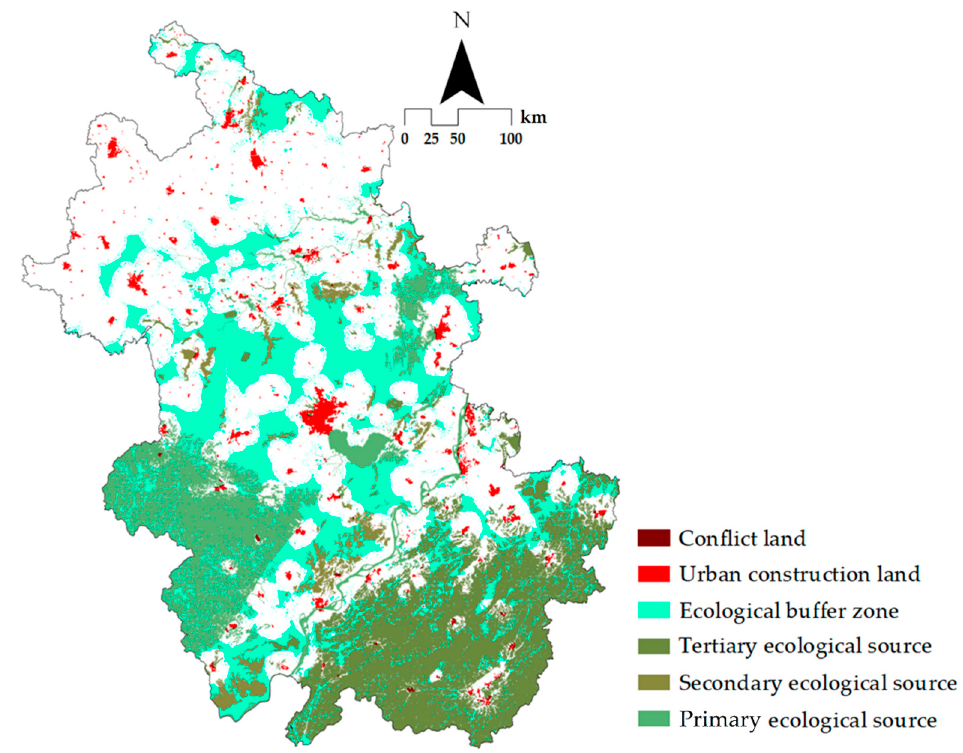
Figure 12. Conflict areas between ecological land and urban expansion.